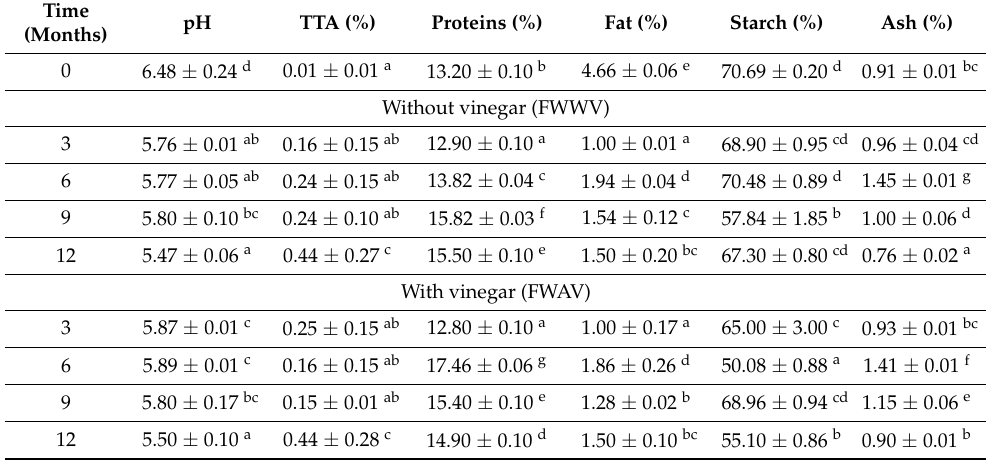
Table 3. Evolution of biochemical properties of durum wheat after various fermentation times without or with the addition of